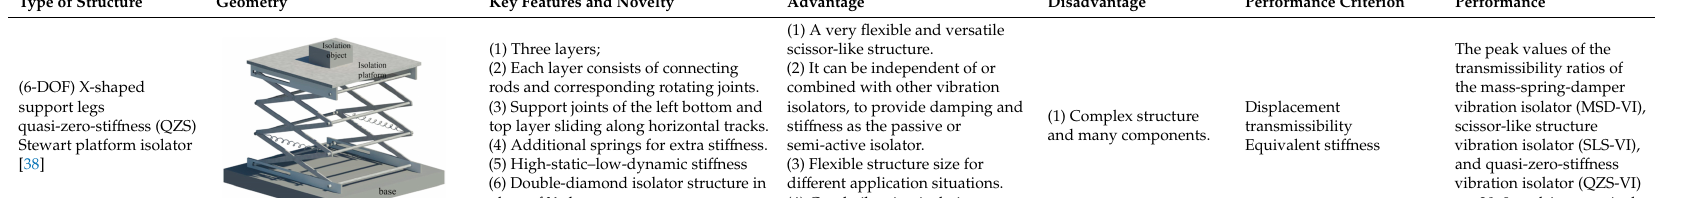
Table 1. Summary of different types of passive vehicle seat isolators.